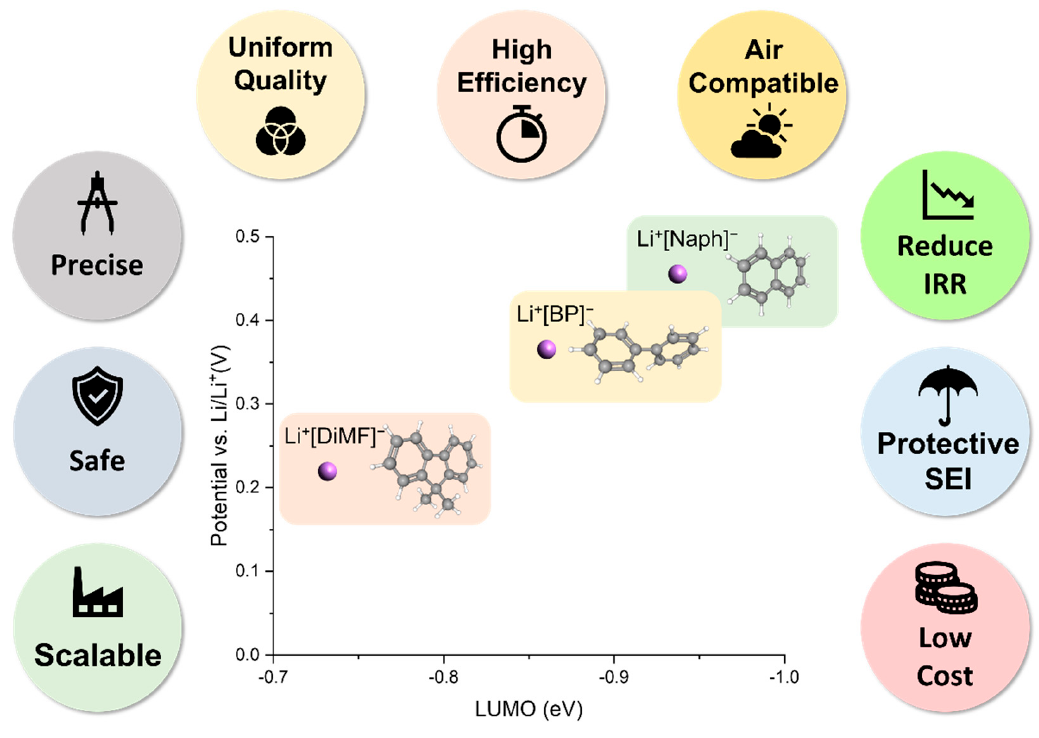
Figure 2. Schematic drawing illustrating the advantages of using PAH-based prelithiation reagents for wet chemical prelithiation.